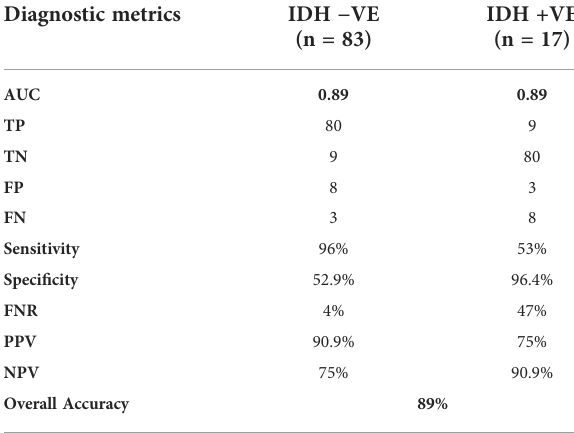
TABLE 6 Performance of best classi fi cation